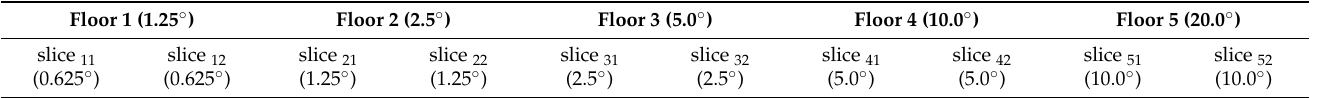
Table 2. Orthogonal cascaded liquid crystal polarization